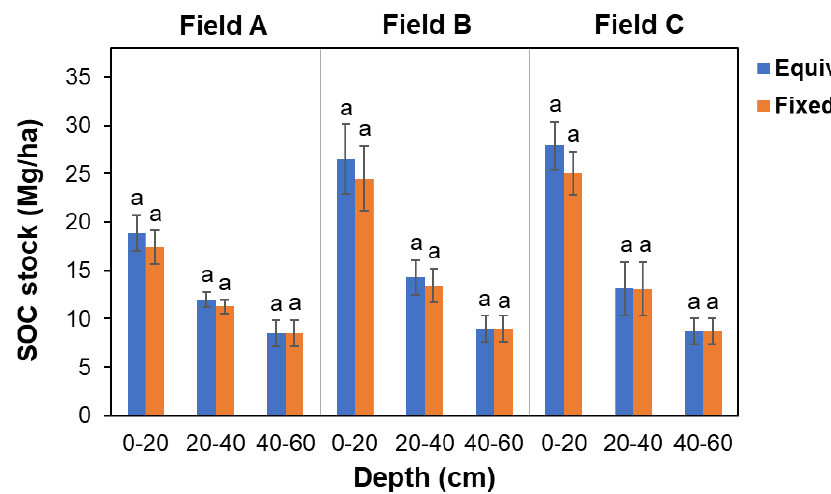
Figure 3. Soil organic carbon (SOC) stocks calculated based on the equivalent mass and fixed depth at three depths in three fields. The similar letters for each depth indicate no significant differences in SOC stocks between equivalent mass and fixed depth ( p < 0.05) for each field.